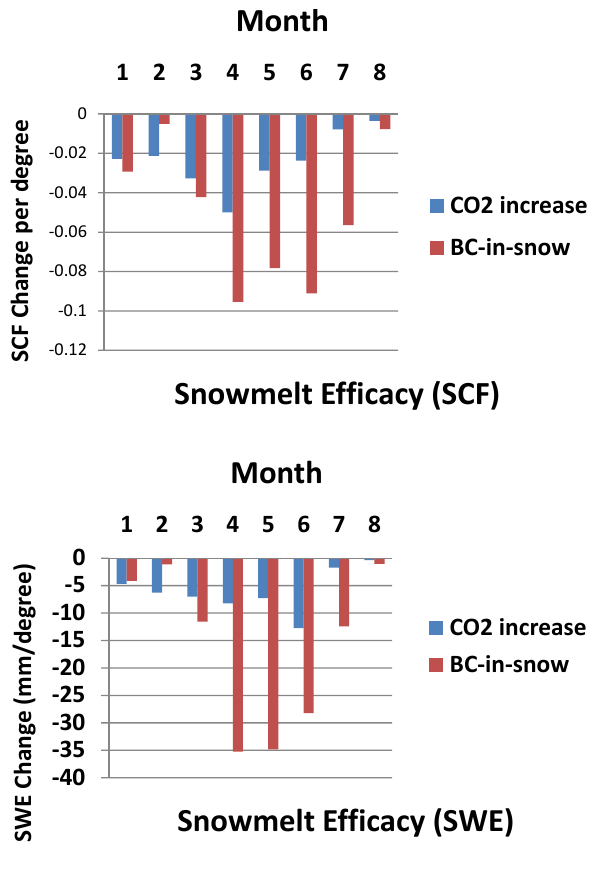
Fig. 12. Ratios of SCF (top) and SWE (bottom) changes against per unit degree of warming induced by CO 2 increase and BC-in-snow, respectively, from January to